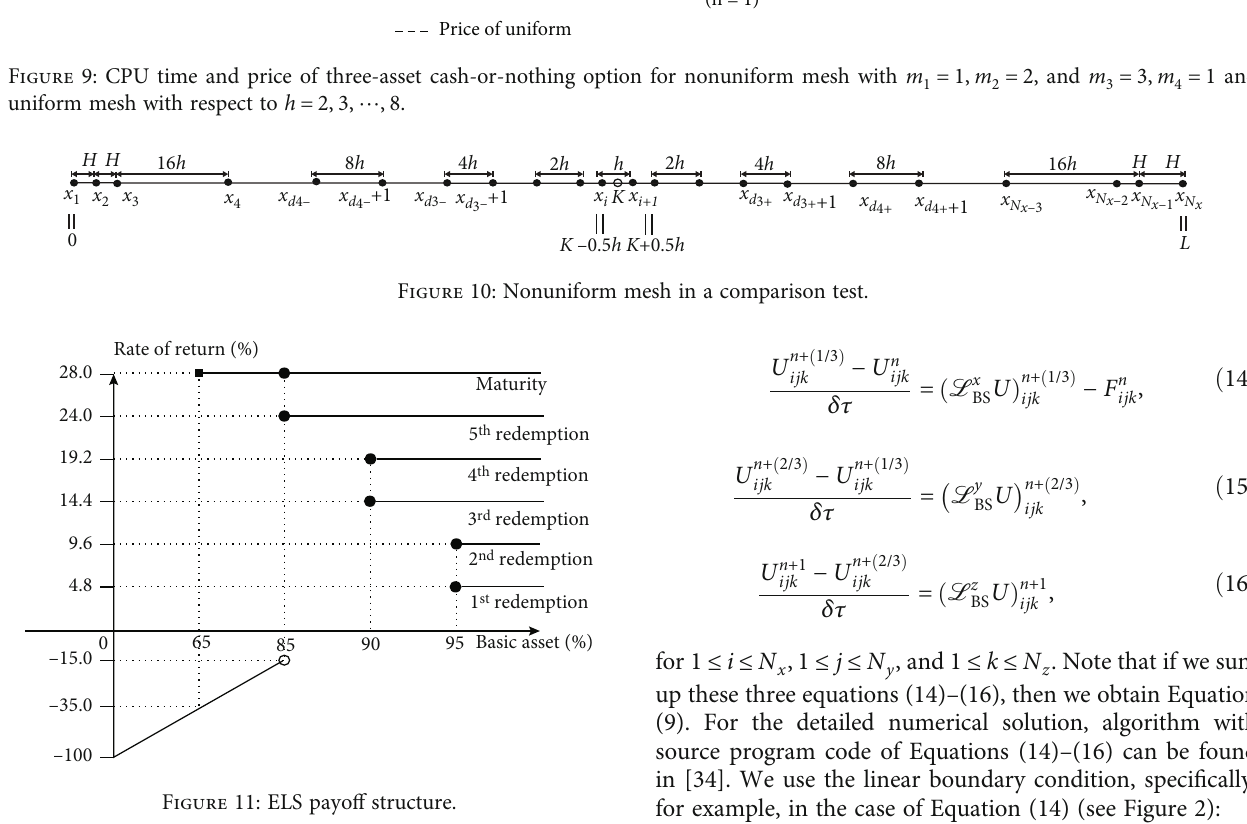
Figure 11: ELS payo ff